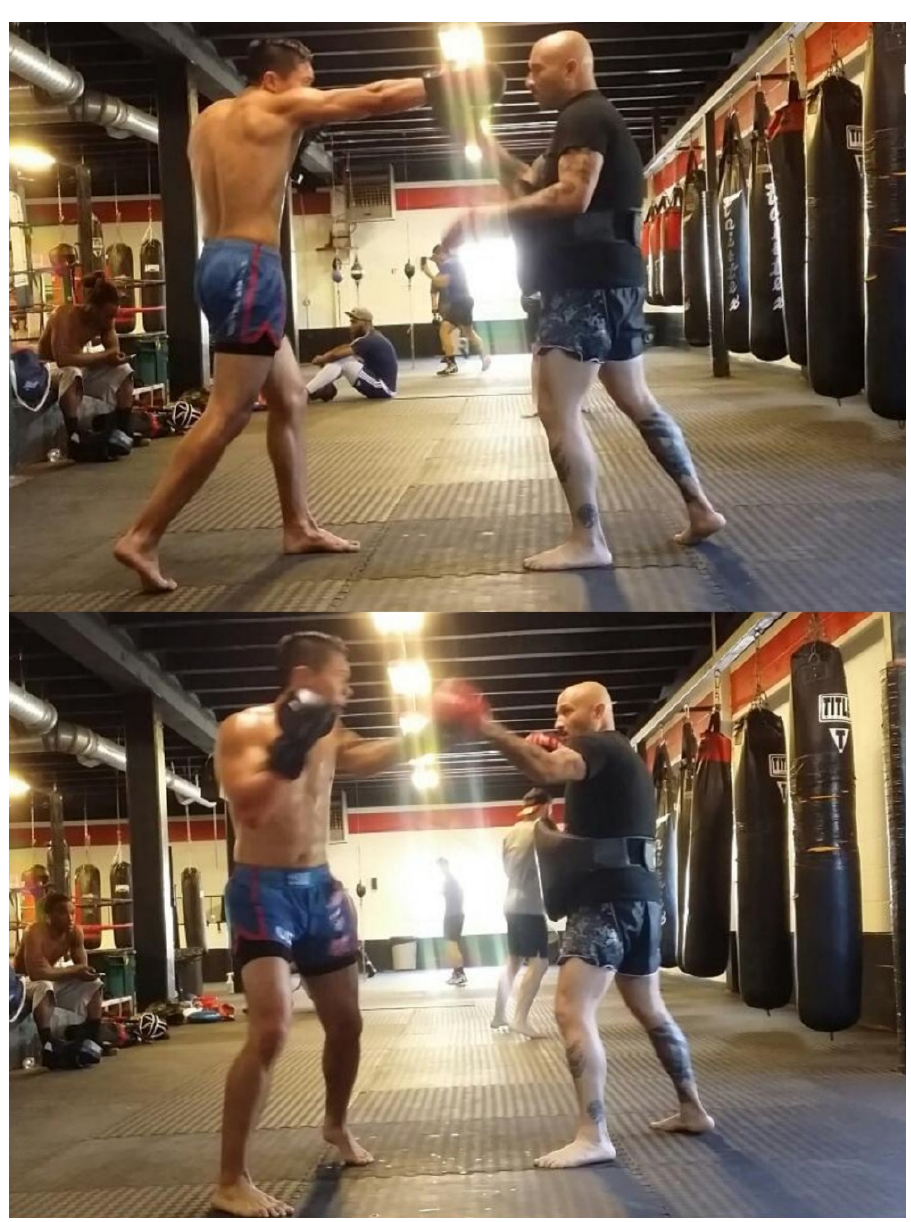
Figure 2. Muay Thai training helps to improve relevant perception and action and can contribute to the cultivation of combat-relevant affordances. Muay Thai training can also contribute to positive emotions, an important component of psychological well-being. Training is fun and produces immediate enjoyment and excitement while training. Training also provides a more long-lasting positive emotion as one pursues lifelong excellence in a highly technical craft. This image demonstrates an orthodox cross ( top ) and orthodox lead hook ( bottom ). Thanks to UFC Coach Bob Perez and Houston Muay Thai in Houston, Texas, for the excellent training.